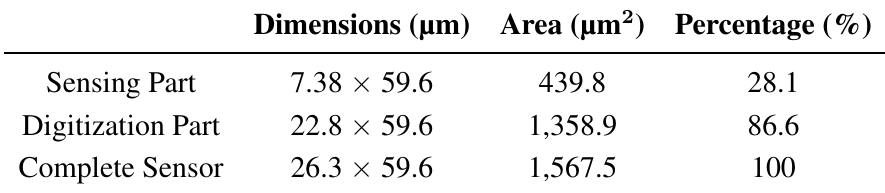
Table 1. Area characterization of the 65 nm